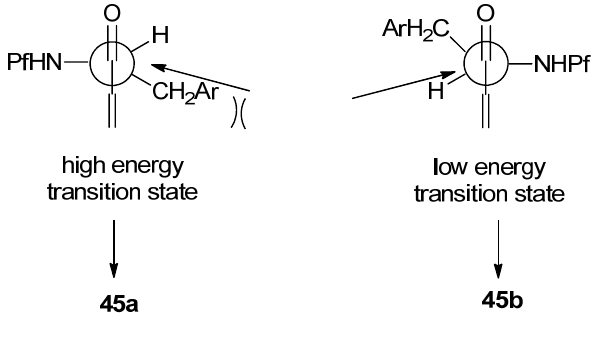
Figure 7. Comparison of Felkin-Ahn model in selective